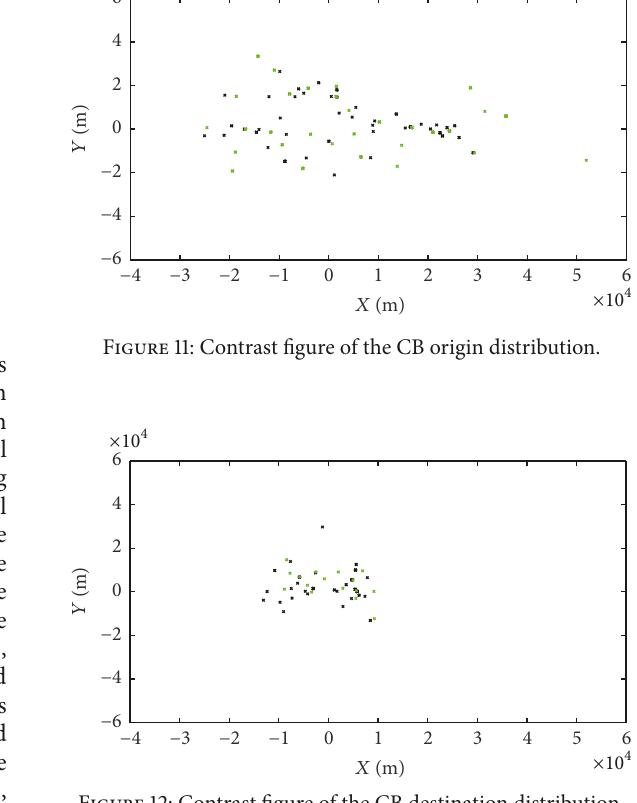
Figure 12: Contrast figure of the CB destination